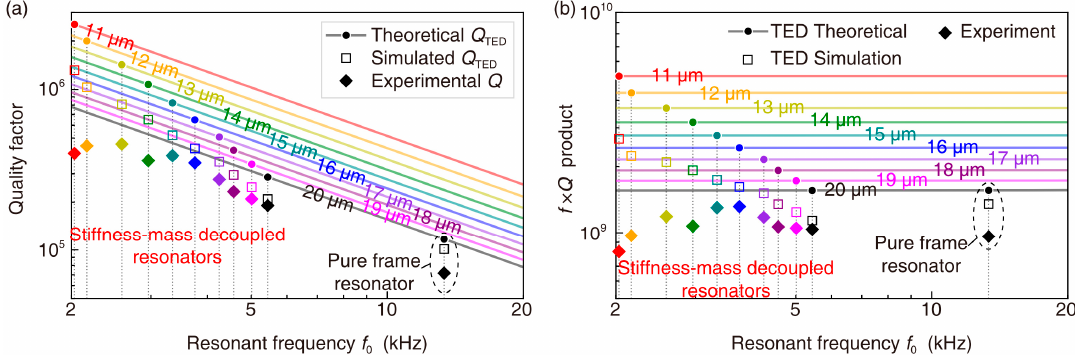
Figure 6. ( a ) Experimental Q s, simulated Q TED ‘s, and theoretical Q TED ‘s of the SMD disk resonators with beam width ranging from 11 μ m to 20 μ m and those of the pure frame disk resonator with beam width of 20 μ m. ( b ) f × Q products obtained by TED theory, TED simulation, and Experiment for the SMD disk resonators with beam width ranging from 11 μ m to 20 μ m and those of the pure frame disk resonator with beam width of 20 μ m.